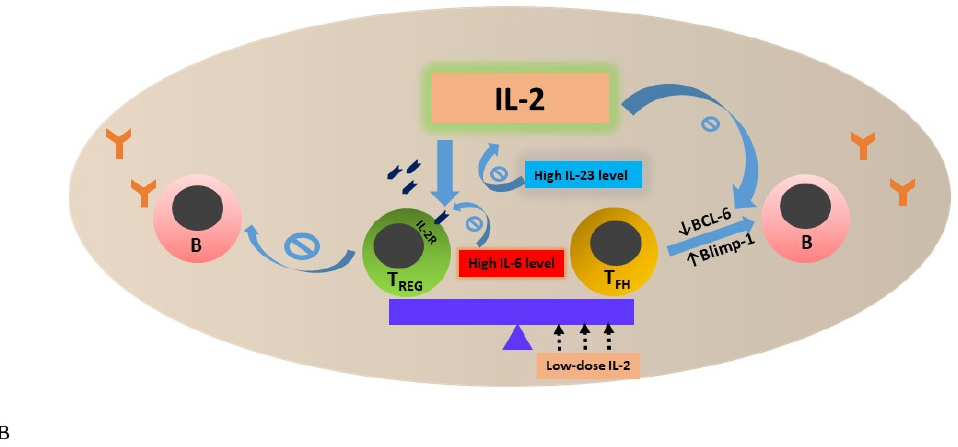
Figure 1. Schematic presentation of the interactions among T FH , T REG , IL-2, IL-2R and B cells in a lymph node (or a second lymphoid organ) in the setting of SLE. ( A ). The reasons for low IL-2 environment in SLE are multifactorial — reduction of IL-2 transcription in T cells, increase in soluble IL-2R that bind to IL-2 (see text) and increase in IL-23 expressions are among some of the mechanisms proposed. Furthermore, high IL-6 expression in active SLE reduces the expression of IL-2 receptors expressed on T REG , leading to reduction of TREG regulatory function — for example, suppression of B cells to produce autoantibodies. These alterations impact peripheral immune tolerance by enhancing the development and differentiation of T FH while suppressing T REG function. Coupled with the lifted inhibition of BCL-6 expression and suppression of Blimp-1 expression by reduced IL-2 signaling, proliferation and function of T FH are fueled, leading to activation of B cells and antibody-forming cells and subsequent increased production of high-affinity autoreactive antibodies in SLE. ( B ). Low-dose IL-2 therapy restores the physiologically balanced activity between T REG and T FH by reversing the low IL-2 environment and stimulating T REG activity via direct binding of IL-2 to IL-2R of T REG . The higher IL-2 microenvironment also restores the balance between BCL-6 and Blimp-1 expression, leading to reduction in autoantibody formation. The impact of low-dose IL-2 therapy on IL-6 and IL-23 in SLE is still unclear. Abbreviations: SLE, systemic lupus erythematosus; IL, interleukin; T REG